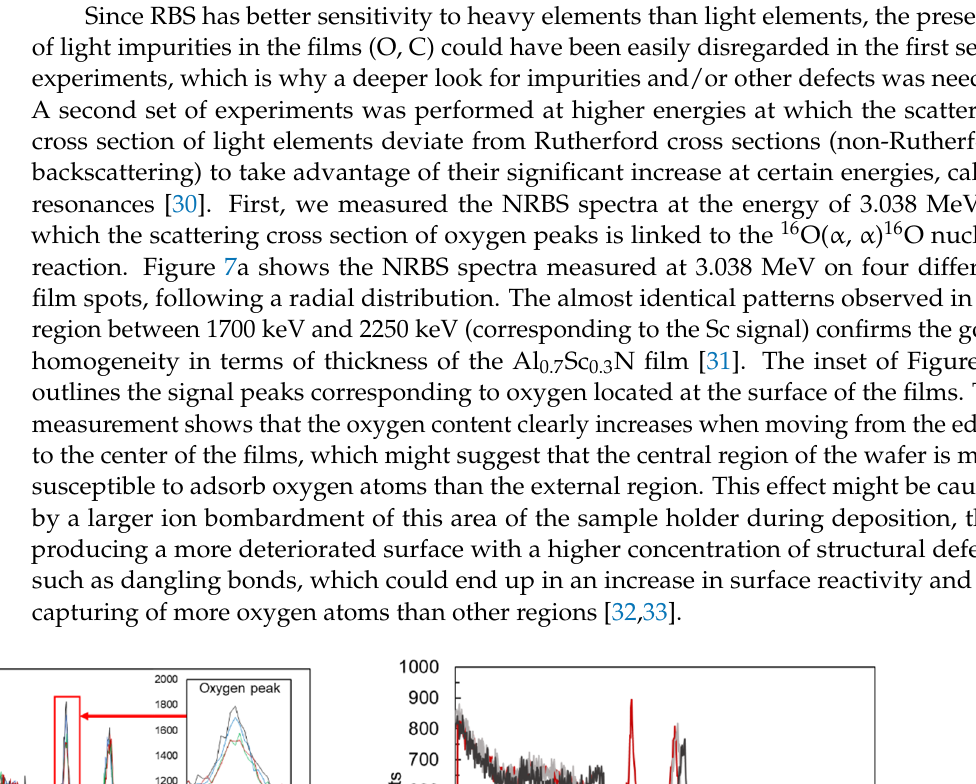
Table 3. RBS atomic composition at different wafer spots.